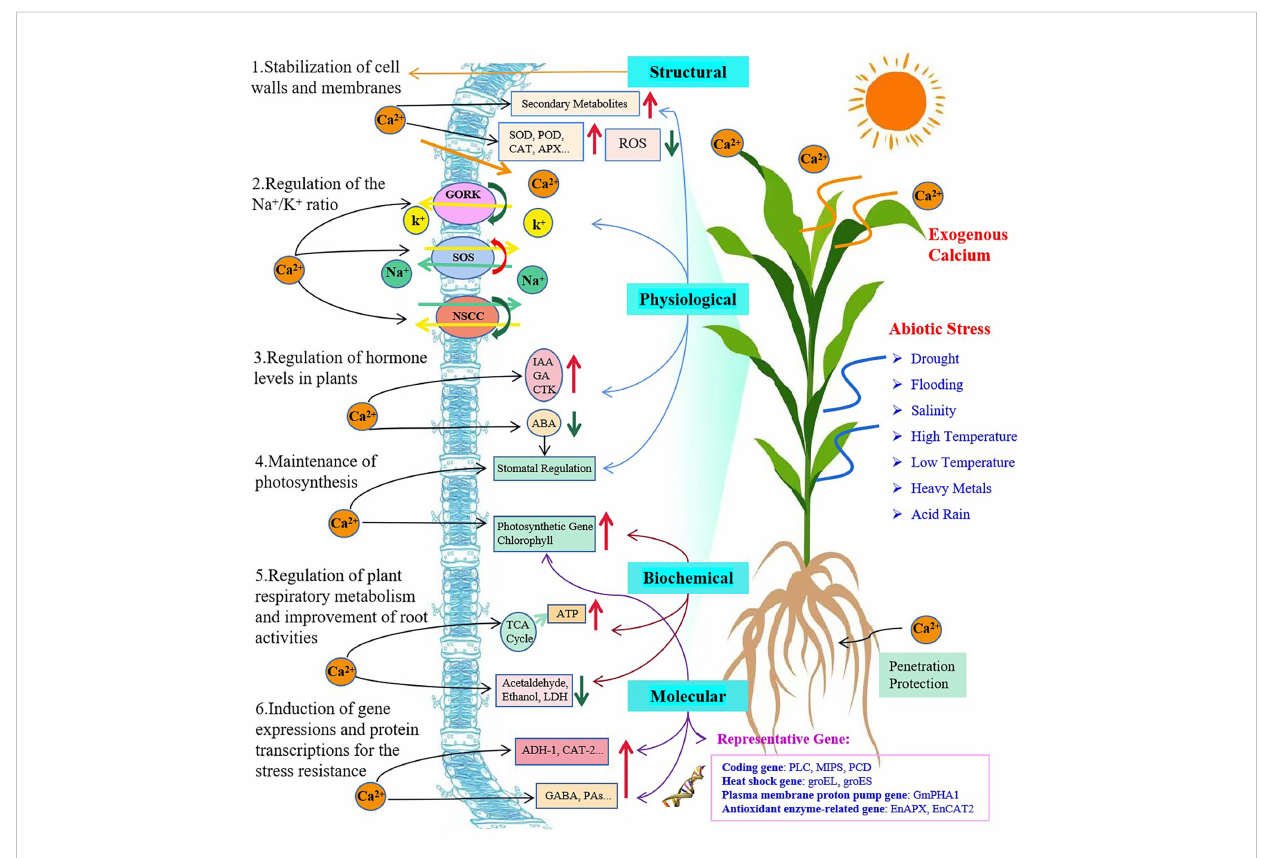
FIGURE 2 Plant self-responses to abiotic stresses and mechanisms of exogenous calcium involved in enhancement of plant stress tolerance. The red and green arrows indicate a promotion/increase or an inhibition/decrease,